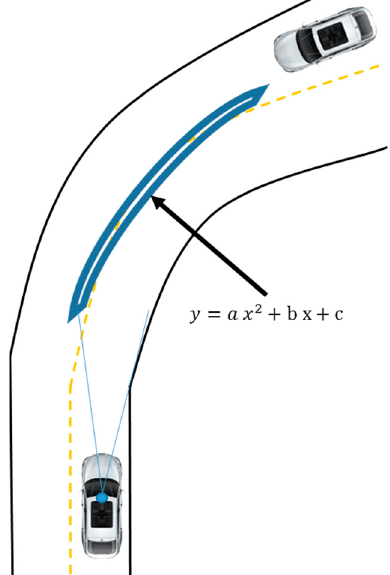
Figure 4. Parabola model of the road